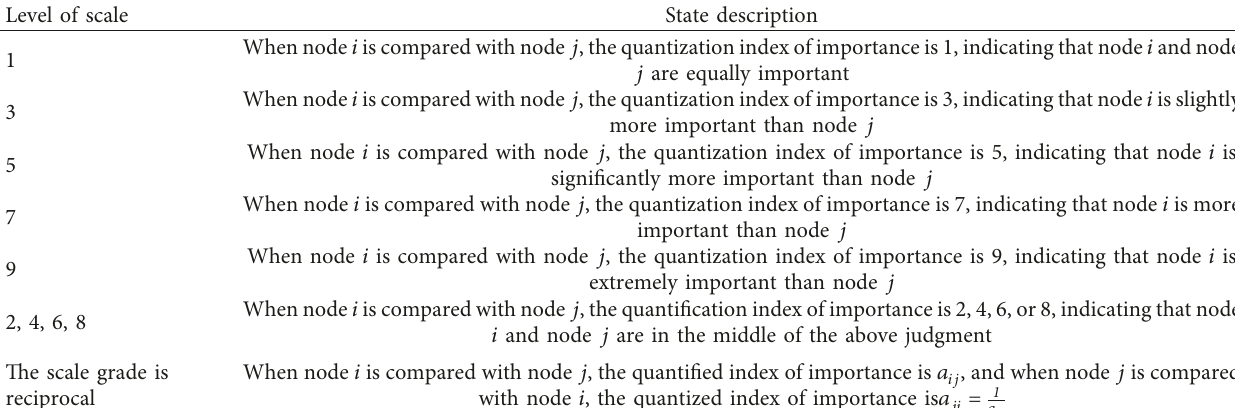
Table 7: Scale grade and state